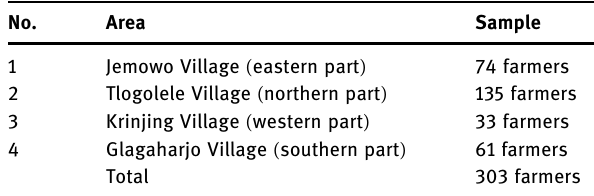
Table 1: Sample detail of each area No.